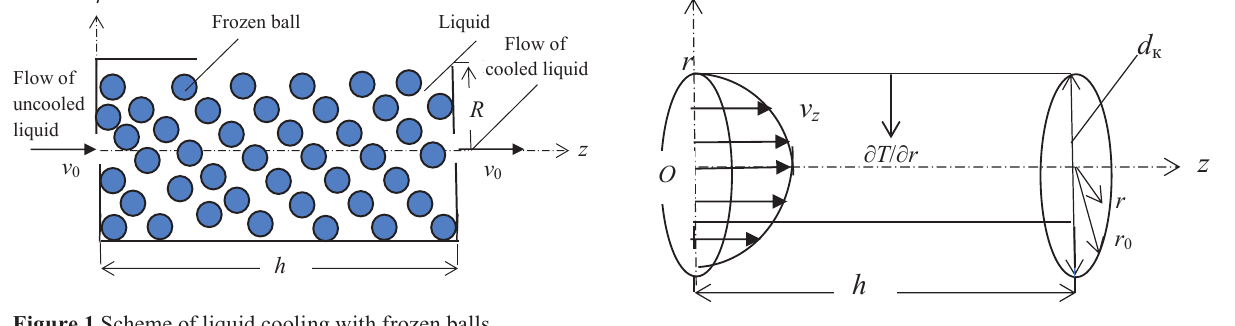
d Figure 2 Scheme to calculate the cooling process of liquid with frozen balls